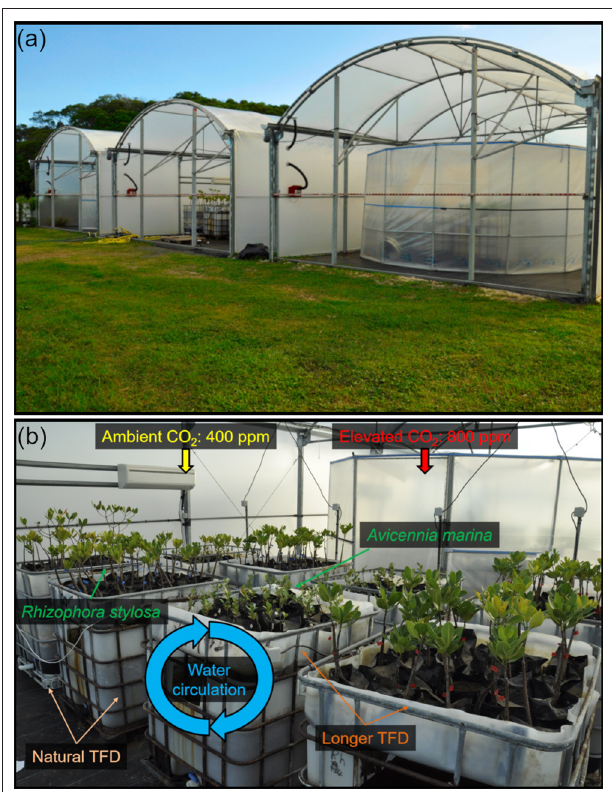
FIGURE 1 | Illustrations of the exterior (a) and interior (b) of the CO 2 facility.